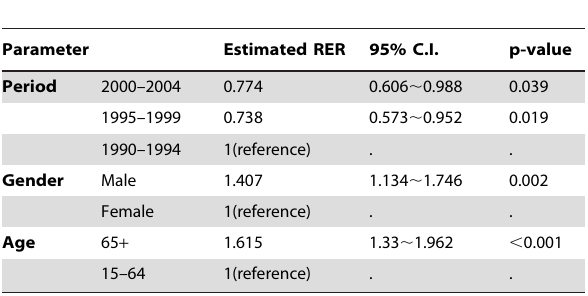
Table 2. Relative excess risk (RER) of relative survival during the first five years after diagnosis of CLL in Taiwan, 1990–2004.